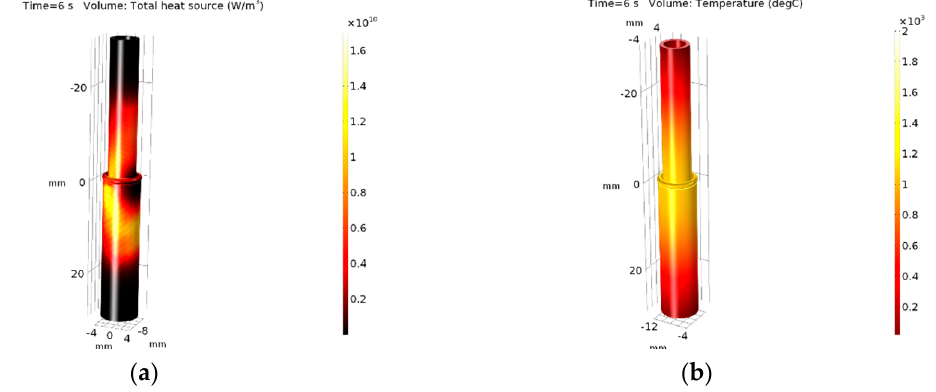
Figure 6. Heating—brazing assembly (copper), ( a ) heat source, ( b ) temperature distribution after 6 s.